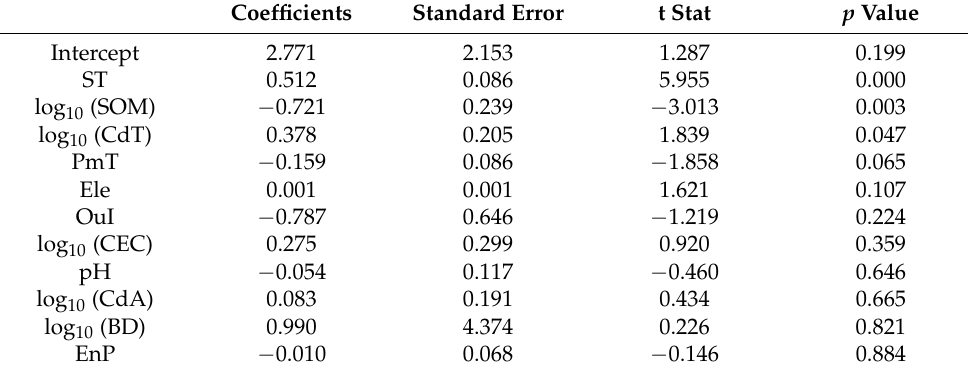
Table 3. Parameters accounting for the multiple regression